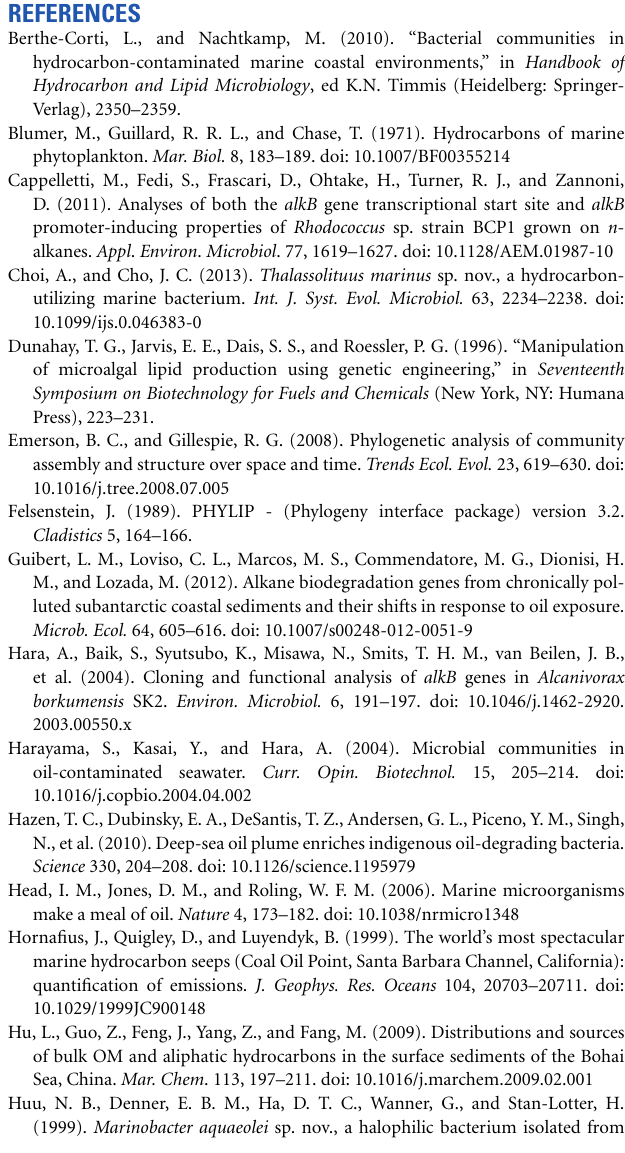
SI Figure 5 | Relative abundance of gammaproteobacterial alkane-degrading genera identified on the basis of 16S rRNA gene sequences for the sites used in this study as a function of the relative abundance of all gammaproteobacteria in the same samples. Data from King et al. (2013). SI Table 1 | Diversity statistics calculated with Mothur. S obs , observed richness; C1, Chao1; H’, Shannon index; 1/D, inverse Simpson’s index; Cov, coverage. Values in parentheses represent 95% lower and upper confidence limits, respectively, for C1, ACE, H’, and 1/D. Because each OPU may be present at multiple sites the sum of S obs at all sites is not equal to the pooled value for S obs